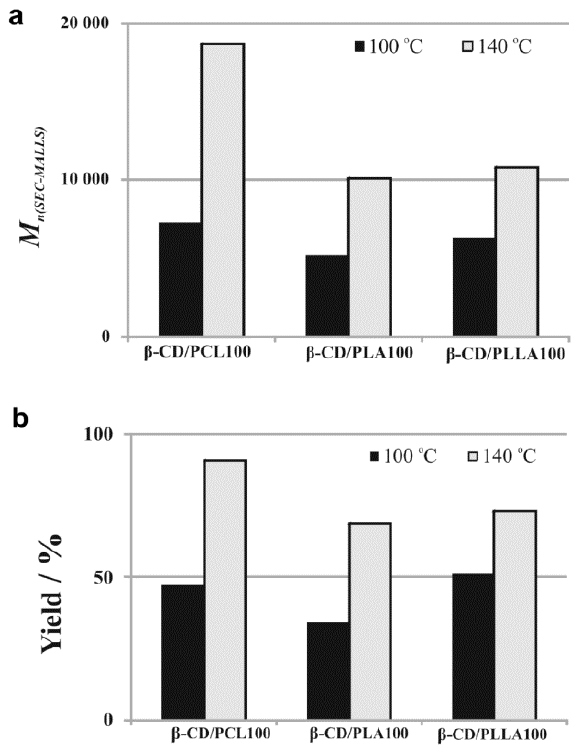
Figure 3. A comparison of the number-averaged molecular weights ( M n ) (measured using SEC-MALLS method) ( a ) and the yield ( b ) of the polymerization products obtained in the presence of β -CD after 48h (( β -CD)/(monomer)= 1/100).